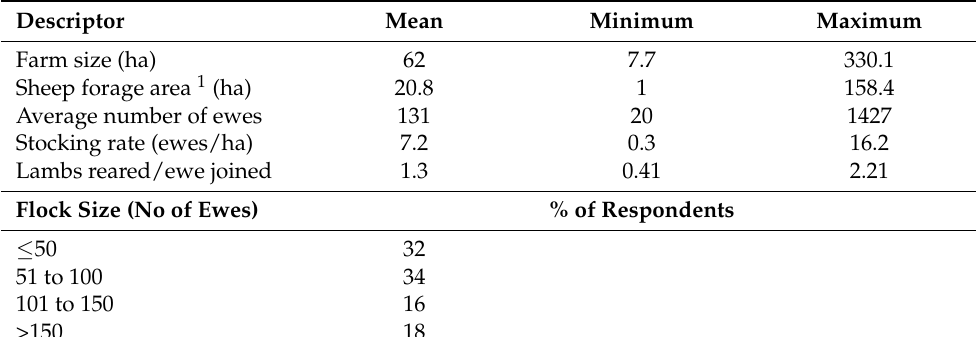
Table 2. Range in farm and flock performance ( n = 177).